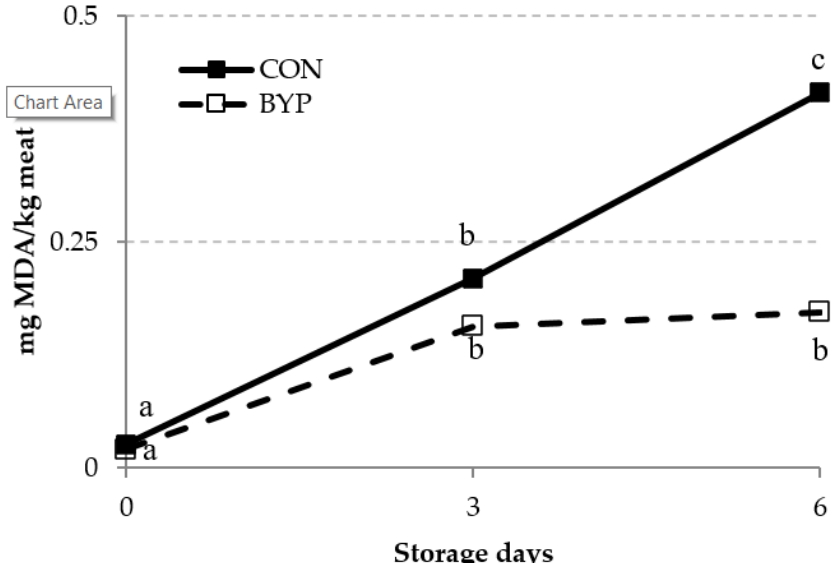
Figure 1. E ff ect of the dietary treatment (CON and BYP) and storage time (0, 3, and 6 days) on the concentration of TBARS (expressed as mg malonaldehyde (MDA) / kg meat) measured in lamb meat stored in unmodified atmosphere at 2 ◦ C. a, b, c Within each dietary treatment, di ff erent superscripts indicate di ff erences between days of storage ( p < 0.05). In repeated measures ANOVA, values of p were 0.134, < 0.001, and 0.095 for diet, time, and diet × time interaction, respectively, and standard error of the mean (SEM) values were 0.0326 and 0.0399 for diet and time e ff ects,